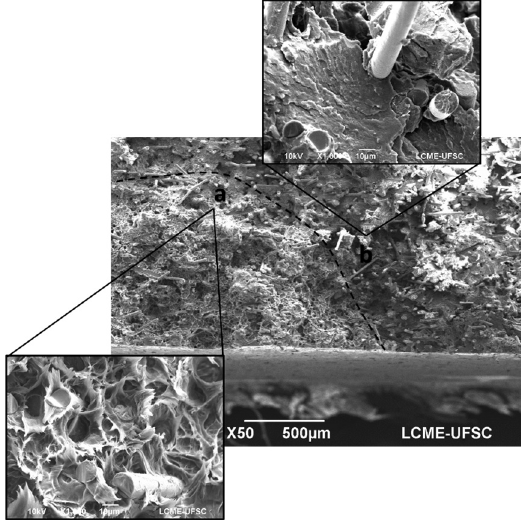
Figure 3: SEM micrograph (x50) of virgin sample, showing the regions of plastic deformation (a) and fragile rupture (b) in detail